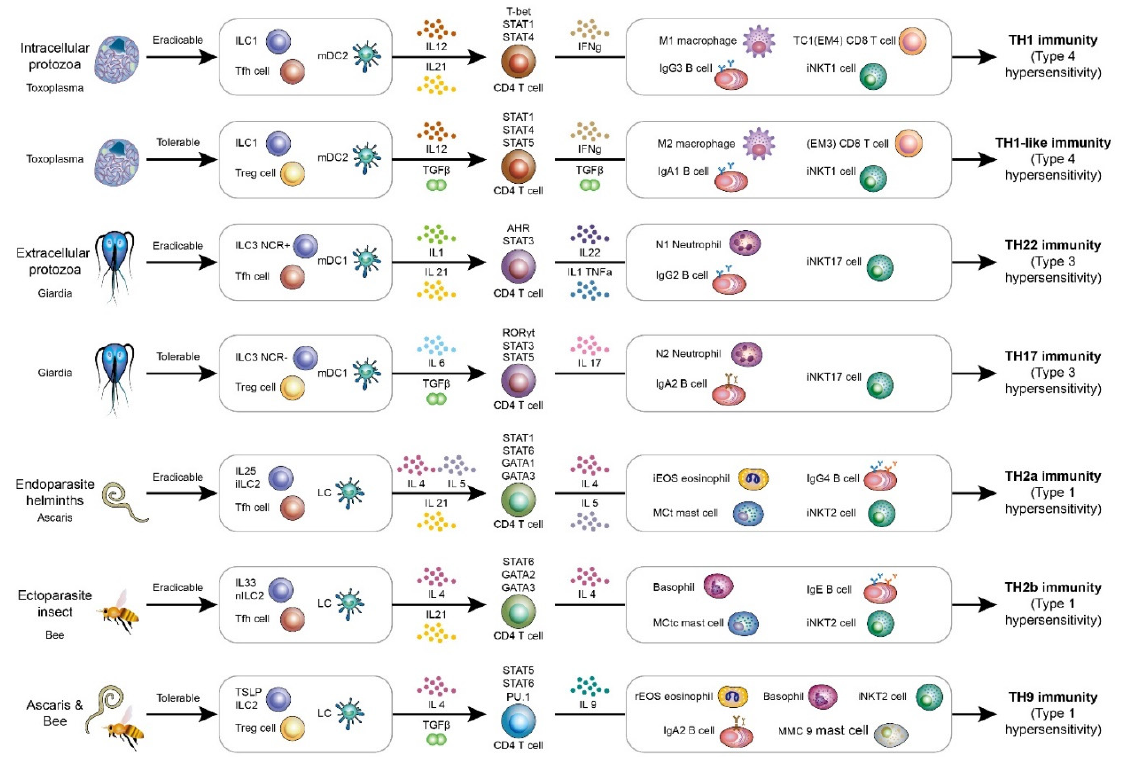
Figure 1. A framework of host immunological pathways against parasitic infections. The host immunological pathways can be divided into Tfh-mediated eradicable (IgG related) or Treg-mediated tolerable (IgA related) immune responses. For intracellular micro-organisms including intercellular protozoa, the eradicable immunity is TH1 immunity, and the tolerable immunity is TH1-like immunity. For extracellular micro-organisms including extracellular protozoa, the eradicable immunity is TH22 immunity, and the tolerable immunity is TH17 immunity. For endoparasites including helminths, the eradicable immunity is TH2a immunity. For ectoparasites including insects, the eradicable immunity is TH2b immunity. For endoparasites and ectoparasites, the tolerable immunity is TH9 immunity.